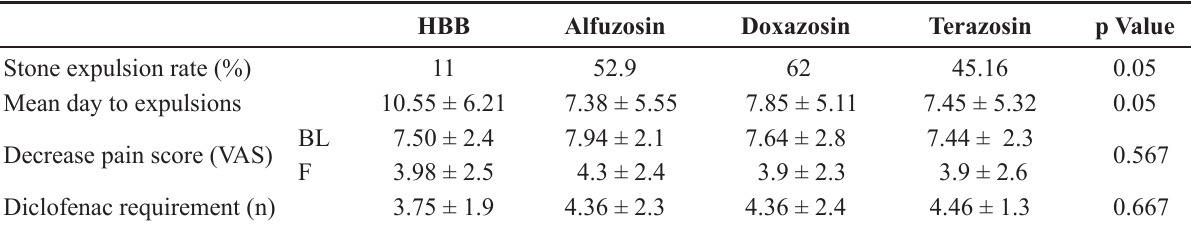
Table 2 – Follow-up results of the